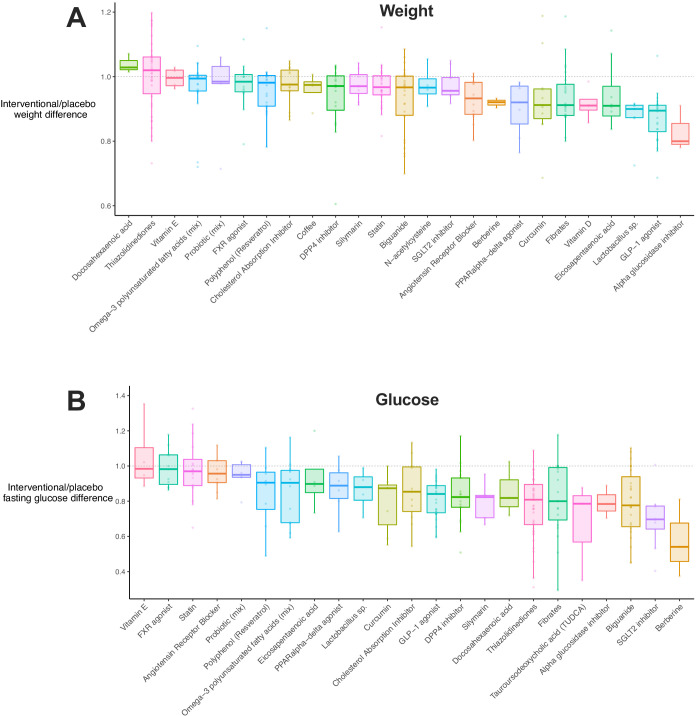
Weight and glucose difference associated with use of each drug class.(A) Box plot illustrating the difference in weight in interventional animals, expressed as a decimal of the weight of the control animals. Raw data points are plotted for each drug class. (B) Box plot for difference in fasting glucose in interventional animals, expressed as a decimal of the weight of the control animals. Raw data points are plotted for each drug class.Figure 3—source data 1.Results of difference in weight, glucose, and insulin for each drug class.Mean, standard deviation, and 95% confidence intervals for the percentage difference in weight, fasting glucose, and fasting insulin between interventional and placebo animals. ACC, acetyl-CoA carboxylase; ACE, angiotensin-2 converting enzyme; CB1, cannabinoid receptor 1; DPP4 Dipeptidyl peptidase-4; FXR, Farnesoid X receptor; GLP-1, glucagon-like peptide-1; LXR, liver X receptor; PDE, phosphodiesterase; PPAR, peroxisome proliferator-activated receptor; SCD1, stearoyl–CoA desaturase-1; SGLT2, sodium-glucose co-transporter-2; TUDCA, tauroursodeoxycholic acid; and UDCA, ursodeoxycholic acid.